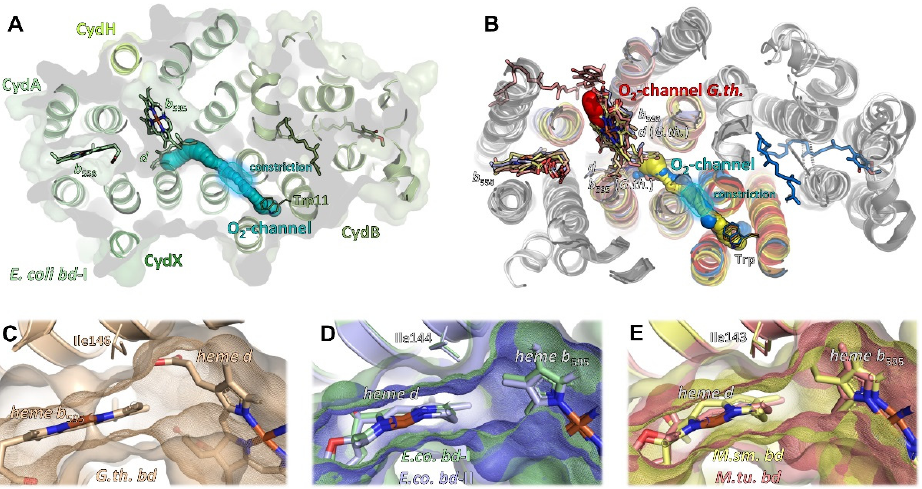
Figure 5. Oxygen channels to the active site in bacterial bd oxidases . ( A ) Oxygen channel in E. coli bd ‐ I (cyan) leading from Trp11 in CydB through the protein core to heme d . The channel features a constriction that is thought to serve as selectivity filter for linear molecules such as dioxygen. ( B ) Other bd oxidases feature an equivalent oxygen channel ( E. coli bd ‐ II in marine blue, M. smegmatis bd in yellow, M. tuberculosis bd in salmon) with a similar constriction. Only G. thermodenitrificans bd , as a consequence of the altered arrangement of the heme groups, features a very short channel (red) from the opposing side of the enzyme and leading directly to the active site heme d . ( C – E ) A conserved isoleucine residue (shown as thick lines) blocks diffusion of dioxygen between hemes b 595 and d by perfect surface complementarity. Hemes are given as sticks, protein surfaces (smooth surfaces) and surfaces of hemes (meshes) are provided to illustrate the excellent surface match. ( C ) G. thermodenitrificans bd , ( D ) E. coli bd ‐ I (pale green) and E. coli bd ‐ II (slate blue), ( E ) M. smegmatis (pale yellow) and M. tuberculosis bd (salmon).